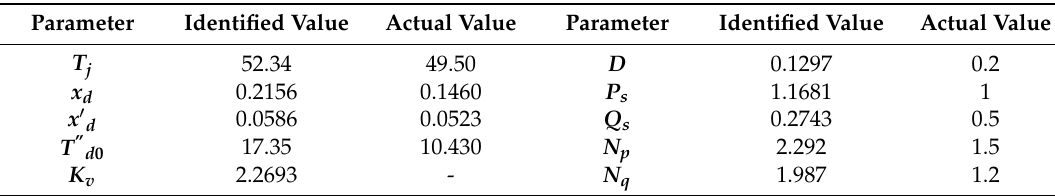
Table 2. Comparison of the identified parameters and the actual parameters of the model for 50 dB signal-to-noise ratio (SNR) inputs (p.u).